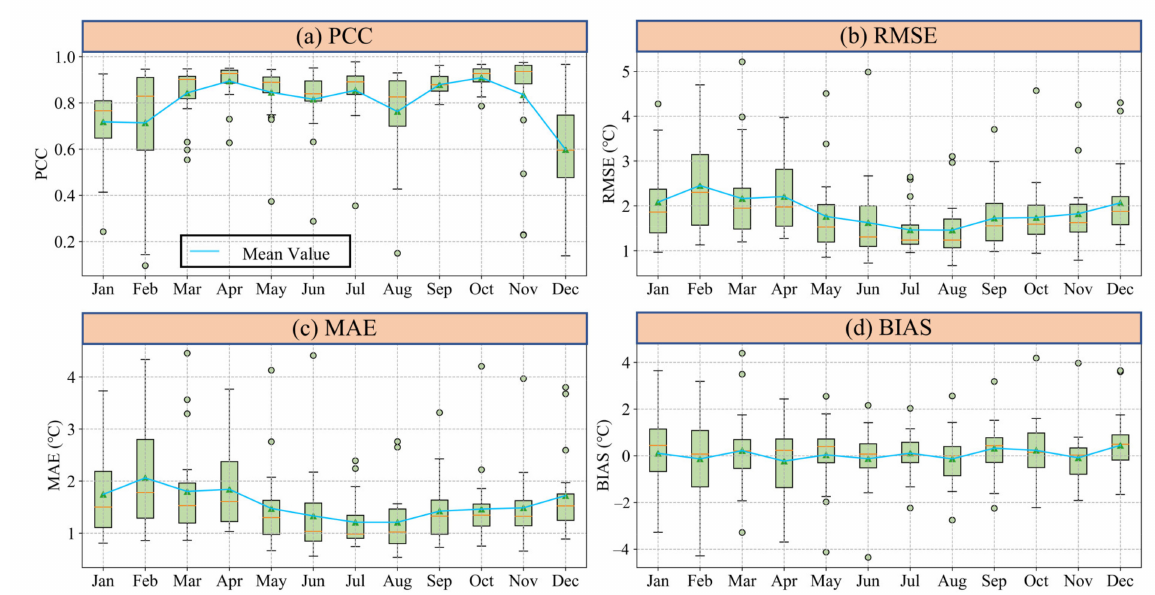
Figure 12. The temporal variations of PCC, RMSE, MAR, and bias in each month. The blue line represents the variations of mean value for each statistical